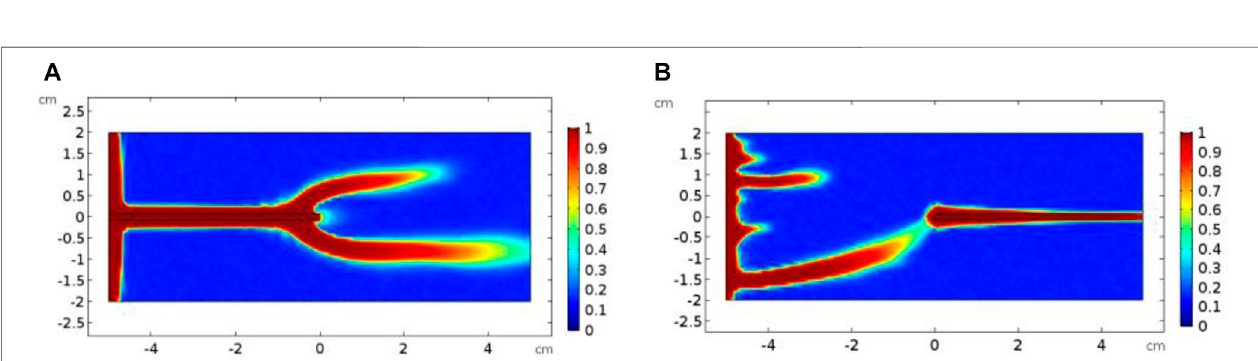
FIGURE 10 | Comparison of dissolution images of isolated fracture core samples with different positions: (A) left-center; (B) right-center.